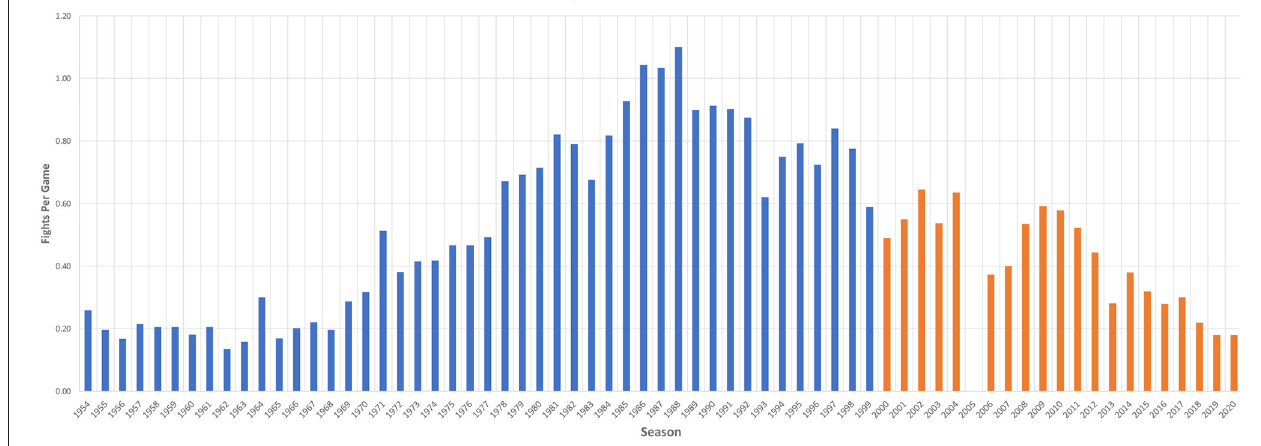
FIGURE 3 | Graph demonstrating historical rates of fighting in the NHL from 1953 to 2020. This figure demonstrates average fights per game from the 1953 to 2020 seasons. Only the average value was included as the number of games played in each season was dependent on the number of NHL teams and length of the season, which has varied over the